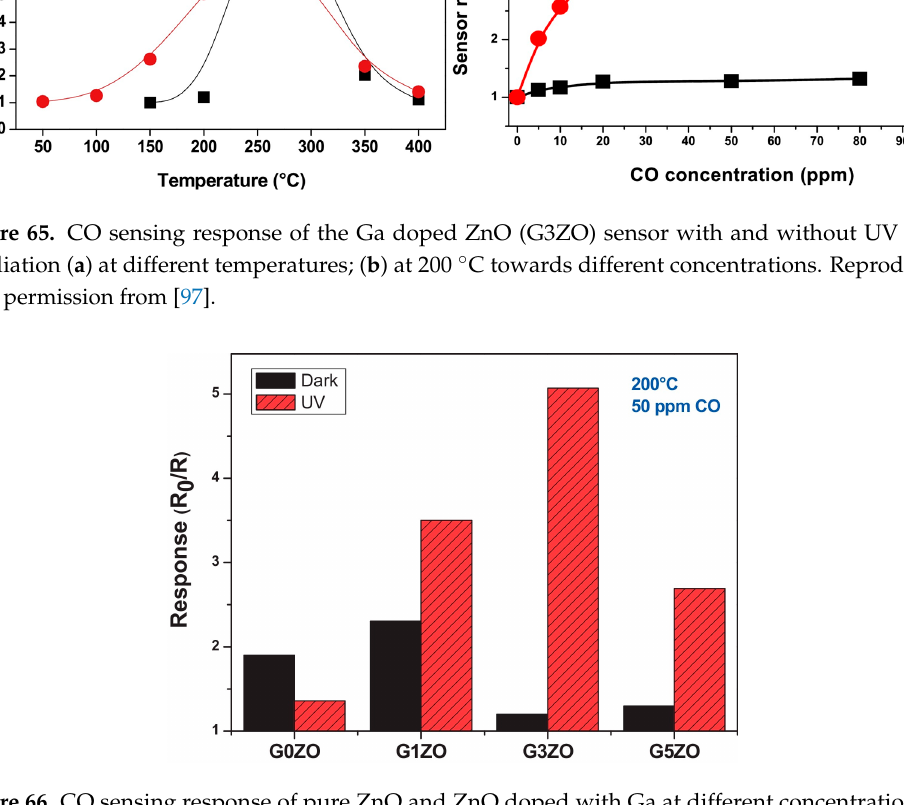
Figure 66. CO sensing response of pure ZnO and ZnO doped with Ga at different concentrations in dark and under UV illumination. Reproduced with permission from [97].